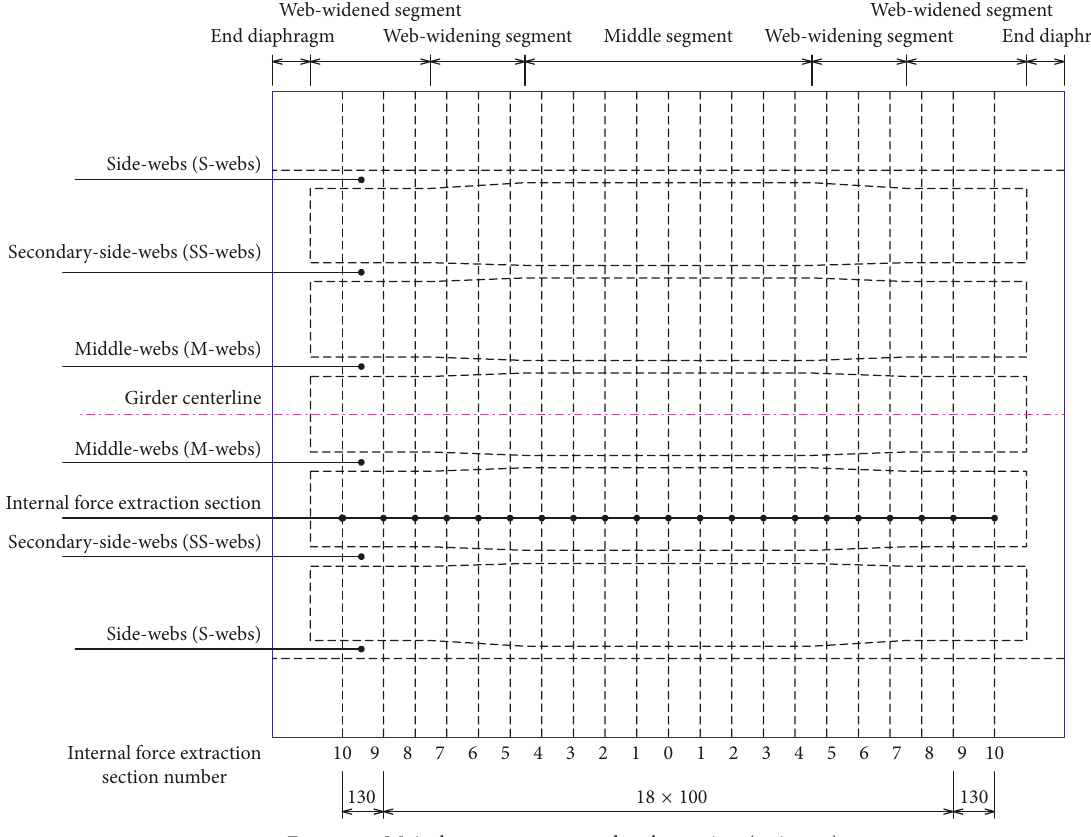
Figure 5: Main beam structure and web naming (unit: cm).